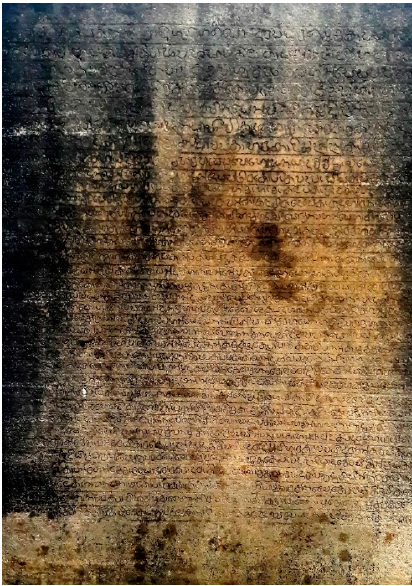
Figure 2. Ruwanwelisaya slab inscription by King Nissankamalla (reign: 1187–1196) mentioning water tax and taxes on chena cultivation. (Photograph by Wasana Sampath in August 2018).